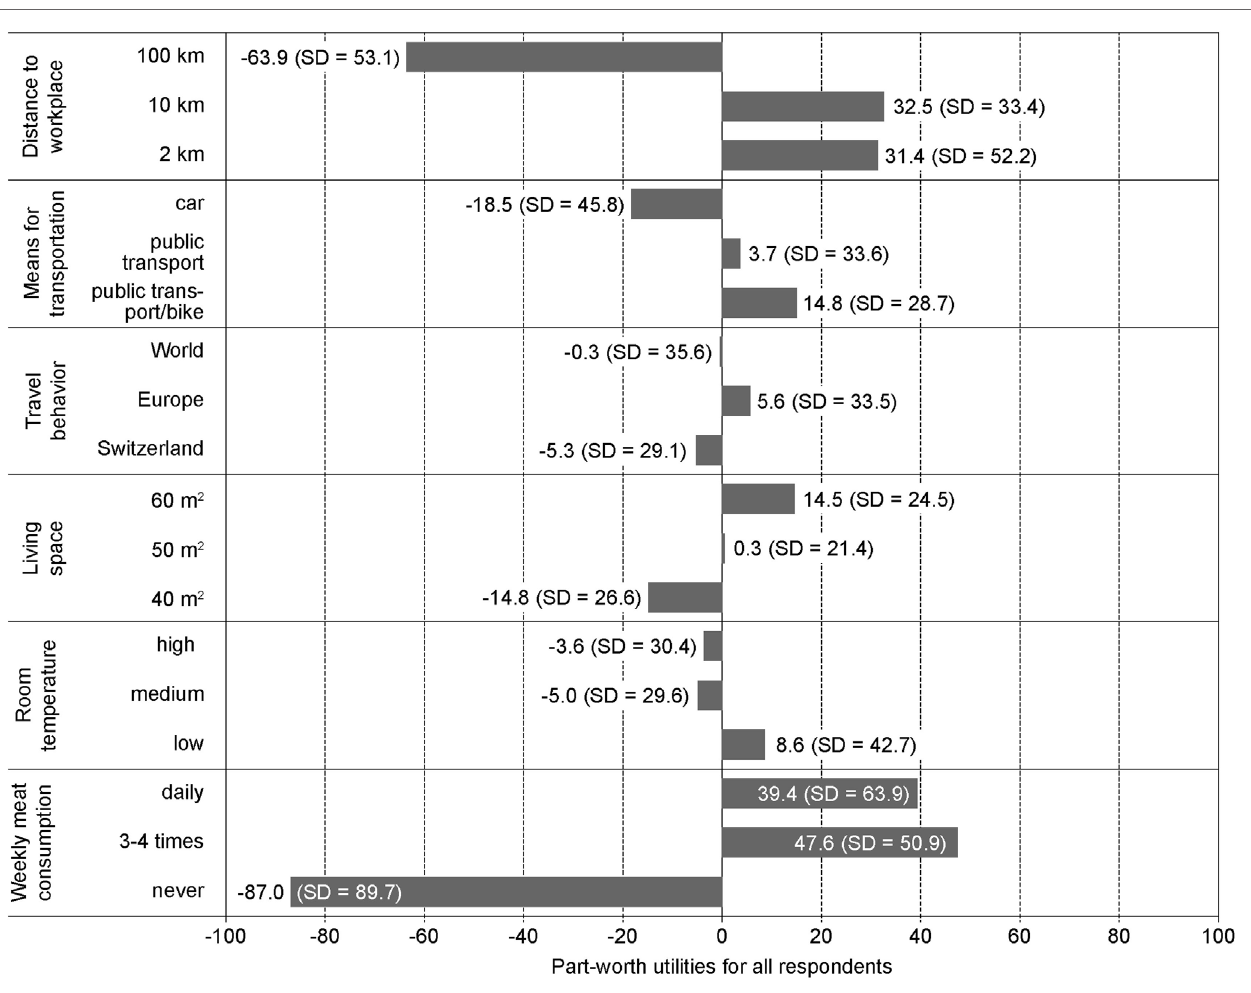
FigUre 1 | aggregated average part-worth utilities of all attribute levels . The part-worth attributes for each attribute sum to 0 ( N =